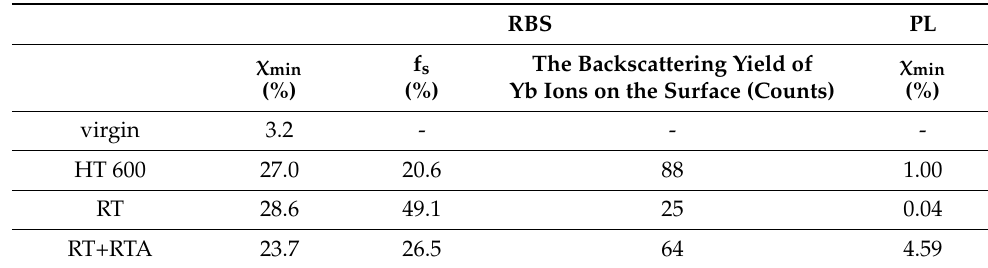
150 keV Yb ions at the fluence of 1 × 10 15 /cm 2 .